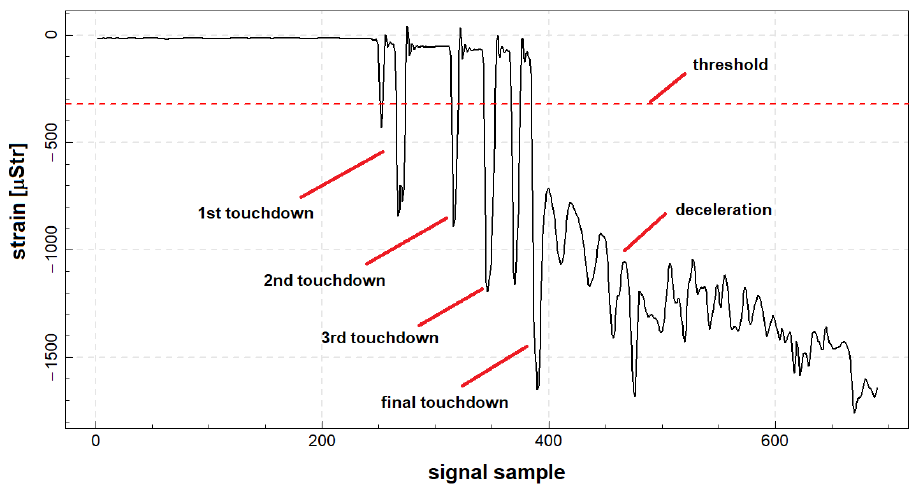
Figure 7. An example of signal acquired by strain gauge located at main gear attachment node during full stop landing with indication of signal threshold for landing